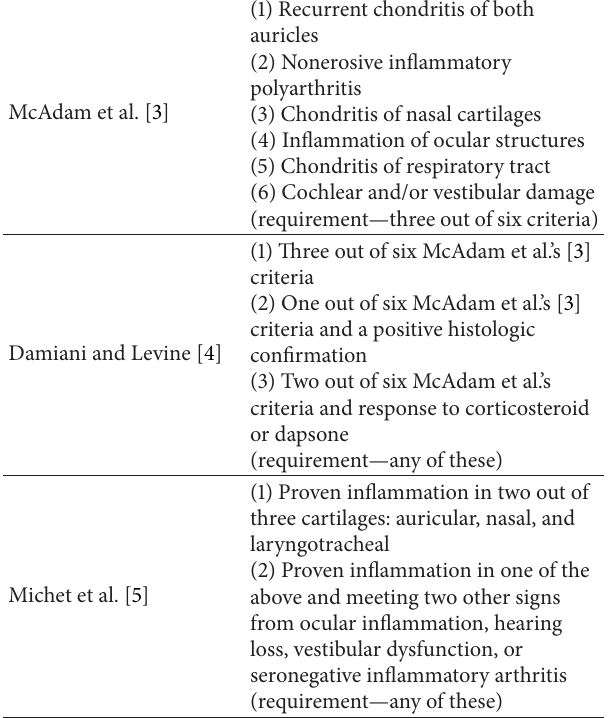
Table 1: Diagnostic criteria for